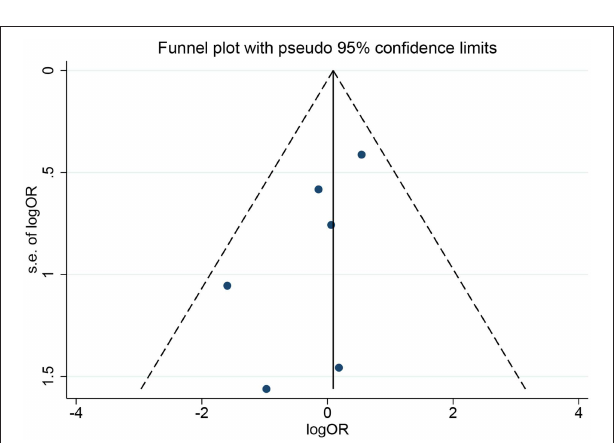
FIGURE 7 | Funnel plots of PFS show a low risk of publication bias.